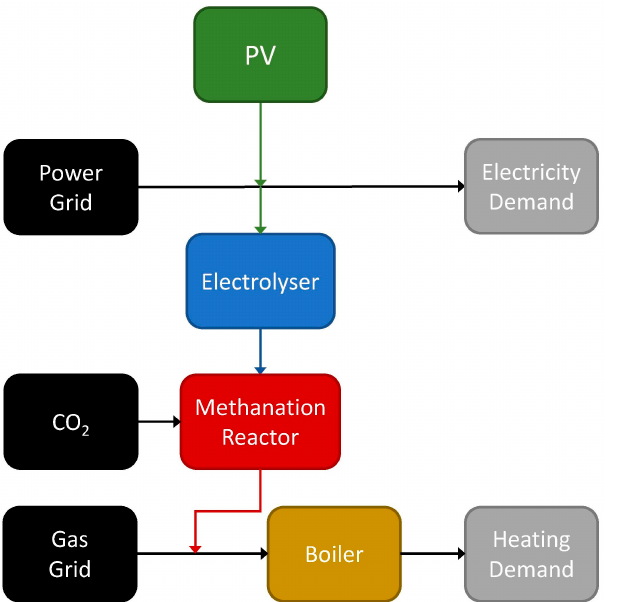
Figure 1. Block diagram of the urban energy district configuration with Power-to-Methane system.